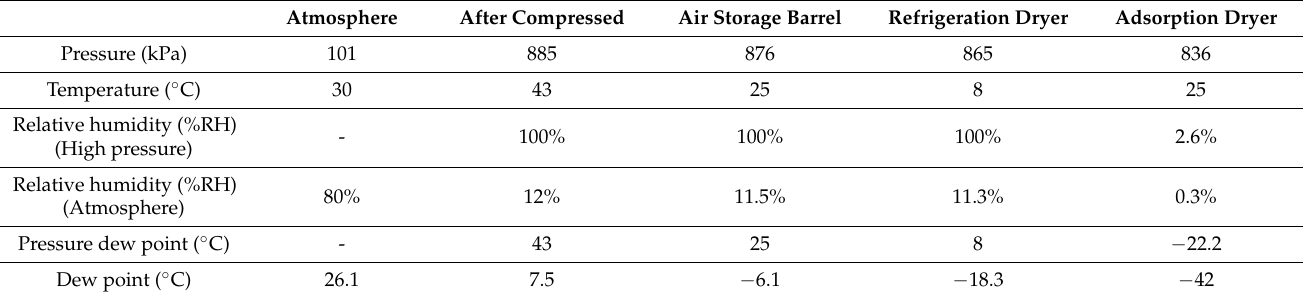
Table 4. The procedure of the compressed air drying system.